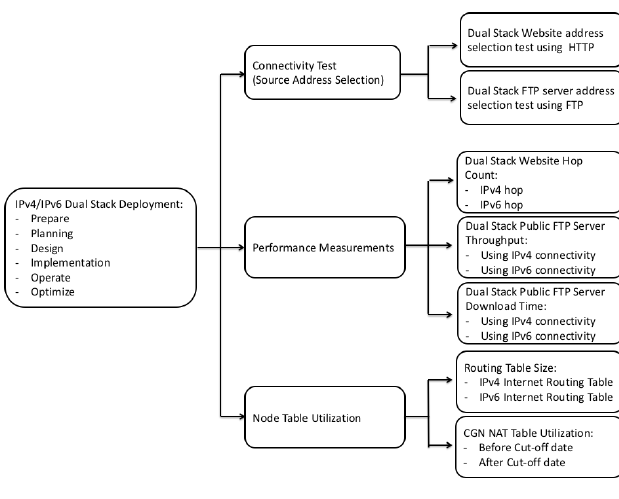
Fig. 5. Deployment and Measurement Flowchart Table 2. PT. ZYX network